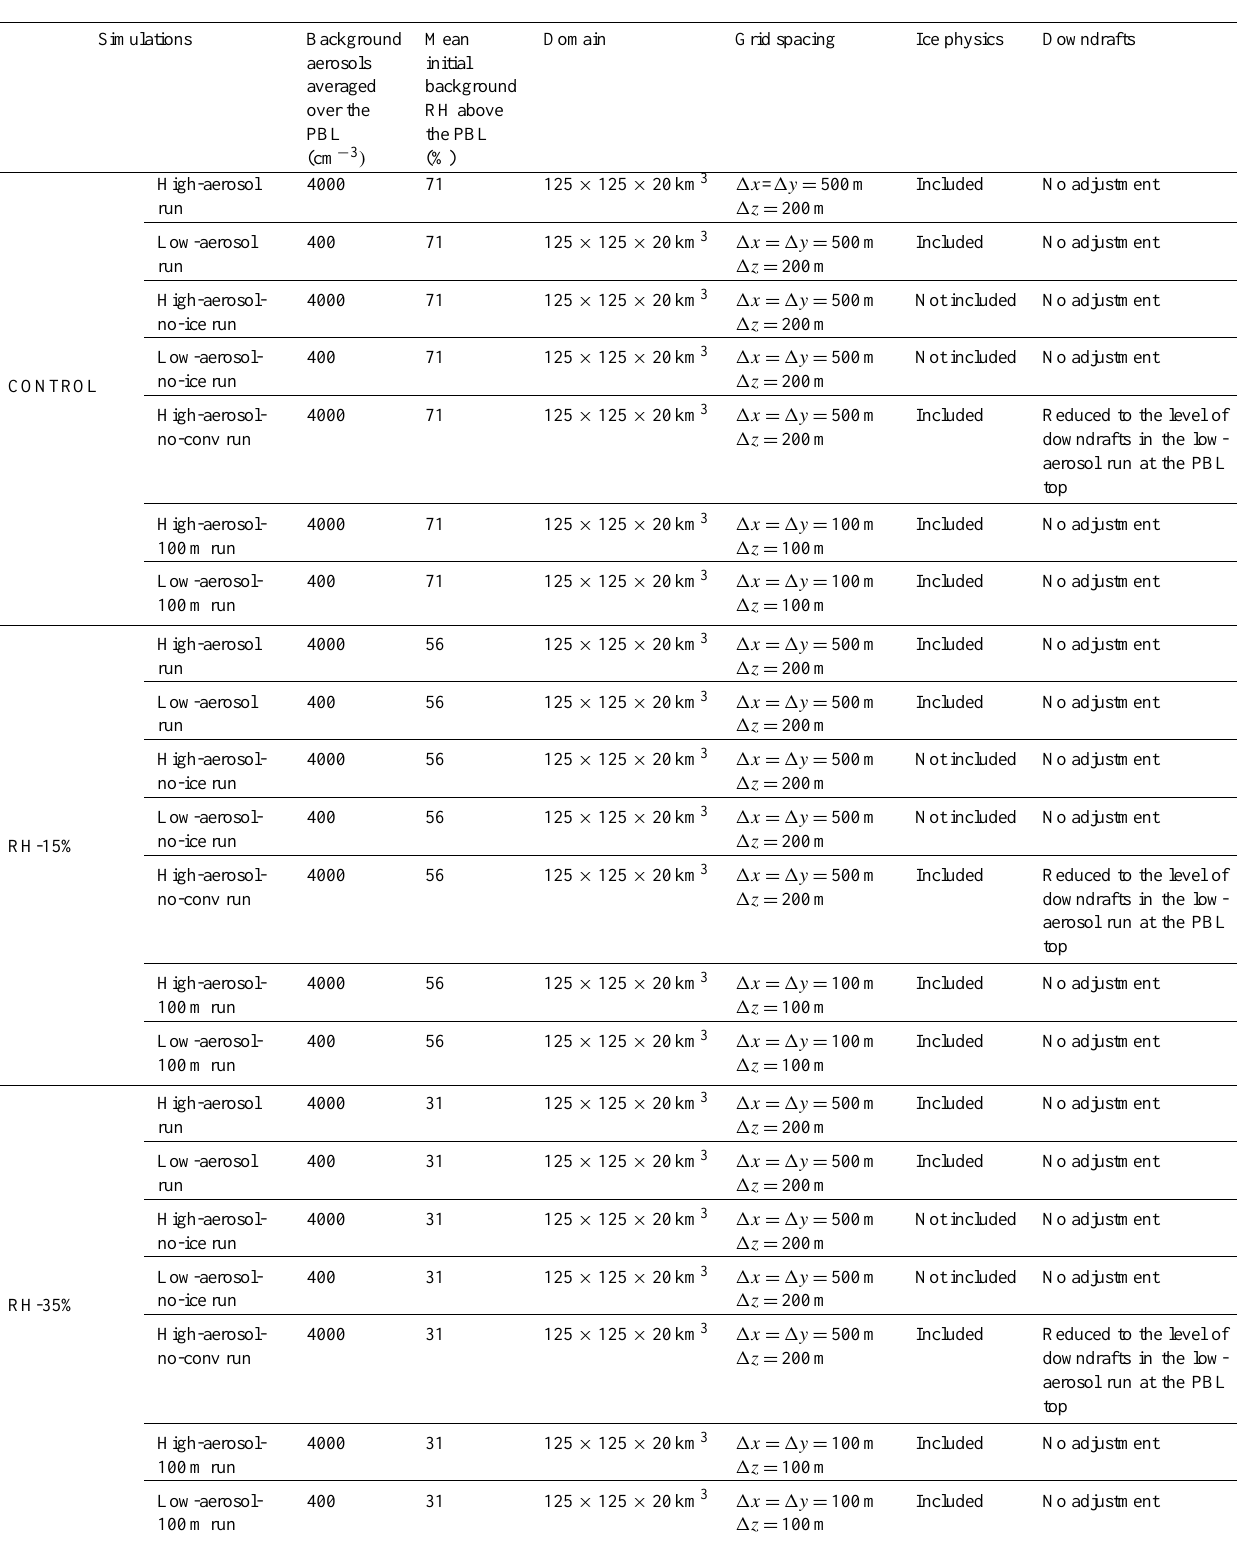
Table 1. Summary of